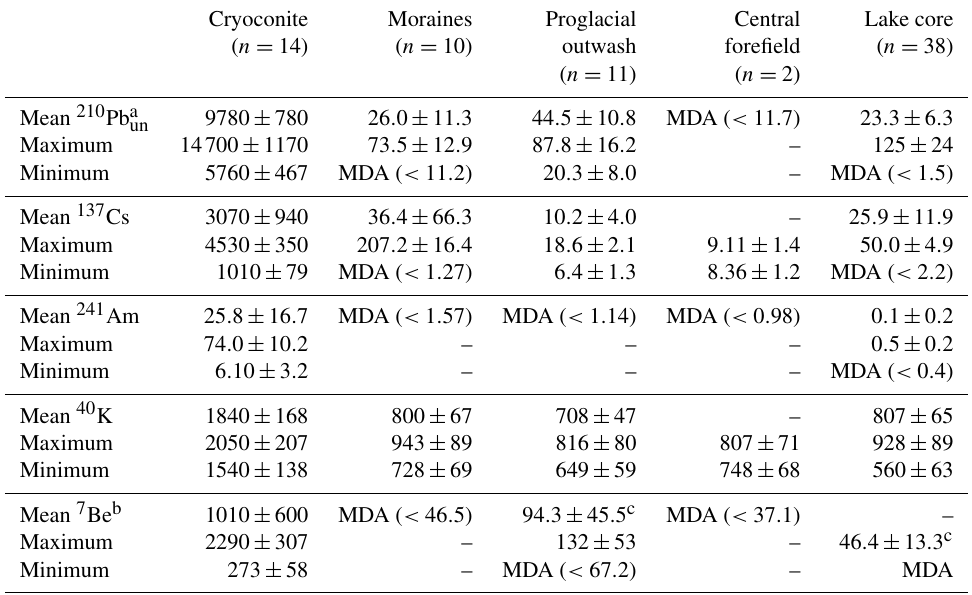
Table A3. Mean ( ± 1SD) concentrations of selected metals (mgkg − 1 ) in cryoconite samples ( n = 14) from the Isfallsglaciären and their enrichment factors. The sample concentrations are compared with the probable effect level (PEL) from the sediment quality guidelines (CCME, 1995).